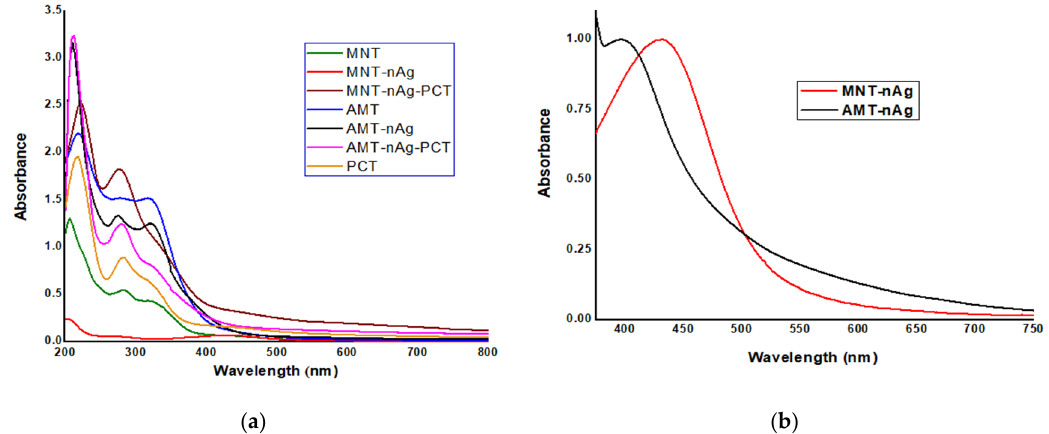
Figure 2. Ultraviolet–visible (UV-Vis) absorption spectra of phytogenic silver nanoparticles and of pectin-coated entities, developed in this study. ( a ) Comparative presentation of UV-Vis absorption spectra of the obtained samples; ( b ) SPR (Surface Plasmon Resonance) bands of “green” synthesized silver nanoparticles (AgNPs).